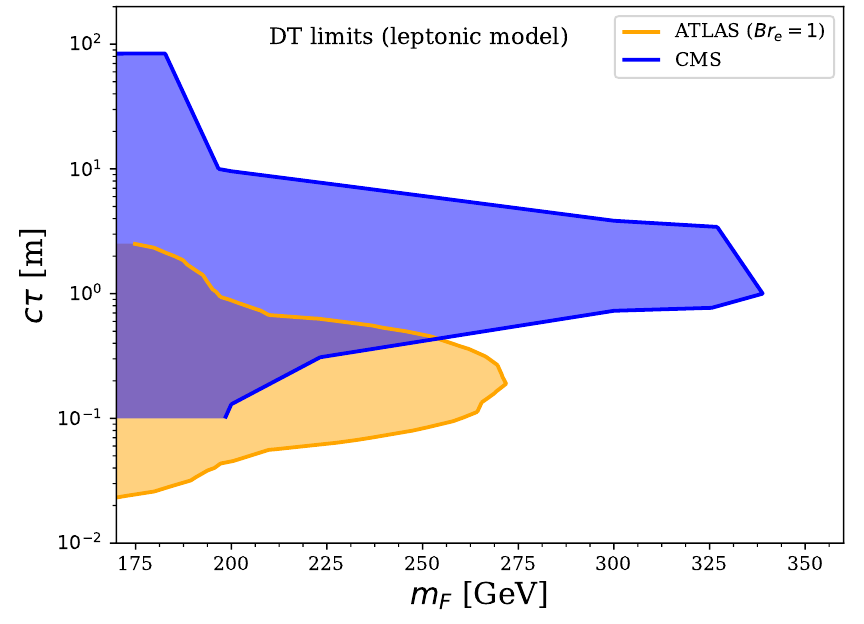
Figure 4 . Region in the c(cid:28) vs m F plane excluded at 95% C.L. by disappearing tracks searches for the leptonic model. We employed the ATLAS 13 TeV (36.1 fb (cid:0) 1 ) and CMS 8 TeV (19.5 fb (cid:0) 1 )